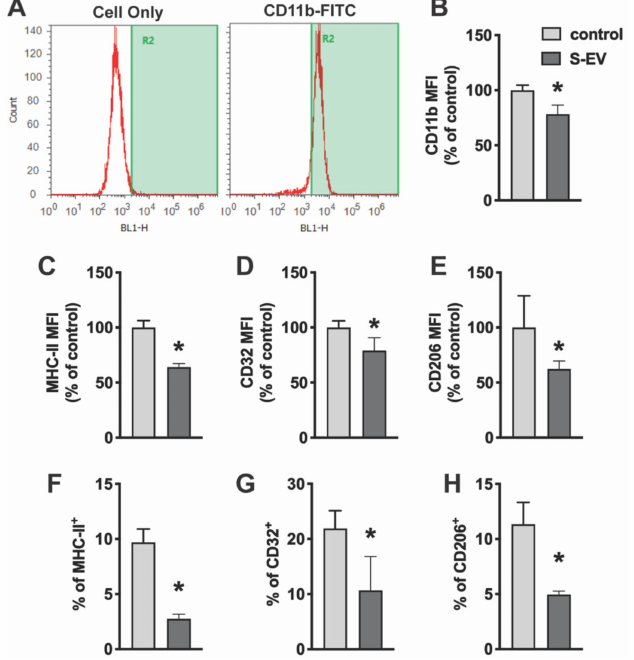
Figure 3. Primary microglia were treated with NDEVs purified from rat neuronal cultures. The expression of microglia/macrophage phenotypic markers, CD11b, CD32, MHC-II and CD206, were detected using an Attune Acoustic Focusing Cytometer. ( A ) Isolated microglia express CD11b. ( B – H ) Data presented show mean fluorescent intensity (MFI) of CD11b ( B ), MHC-II ( C ), CD32 ( D ), and CD206 ( E ) expression or percentage of MHC-II ( F ), CD32 ( G ), and CD206 ( H ) expression on microglia with or without S-EV treatment. Data are mean values ± SD of three to six independent experiments. * p < 0.05 versus